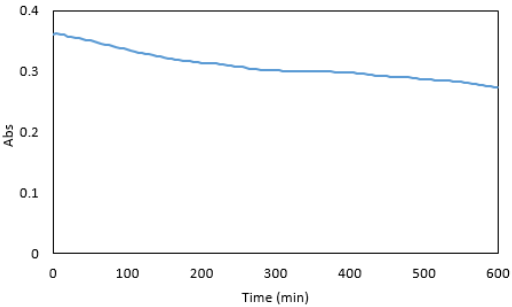
Figure 8. Absorbance of 1 mg · L − 1 Cr VI premixed with the reagents over 600 min.